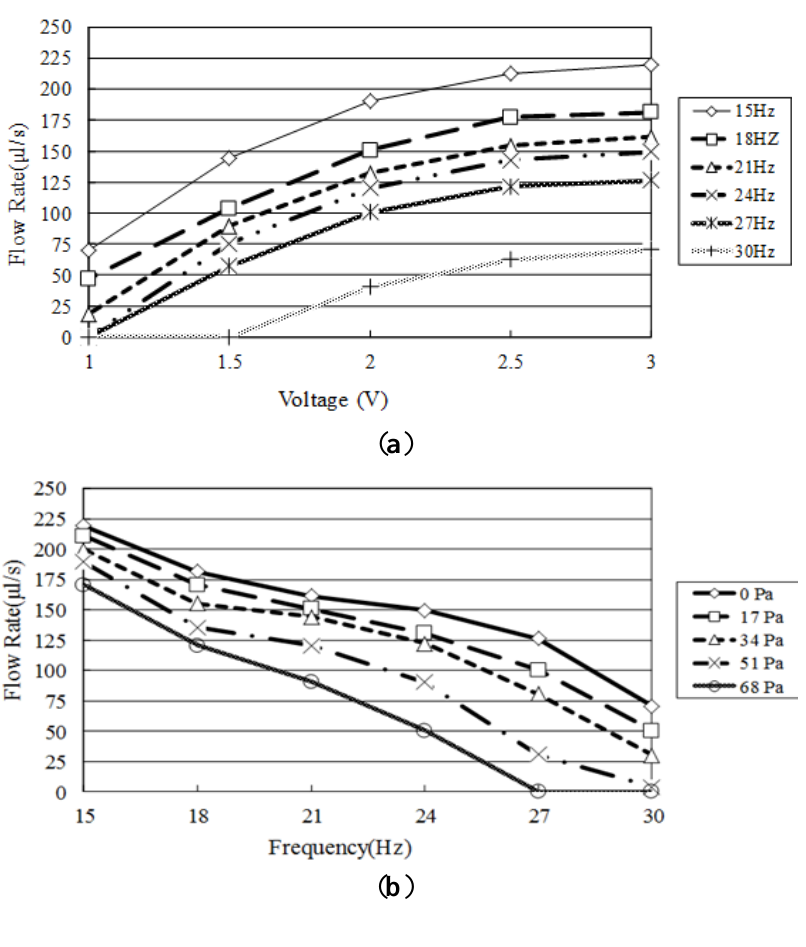
Figure 11. Variation of flow rate with actuation frequency (15~30 Hz) given: ( a ) applied voltage ranging from 1.0~3.0 V, and ( b ) head pressure ranging from 0~68